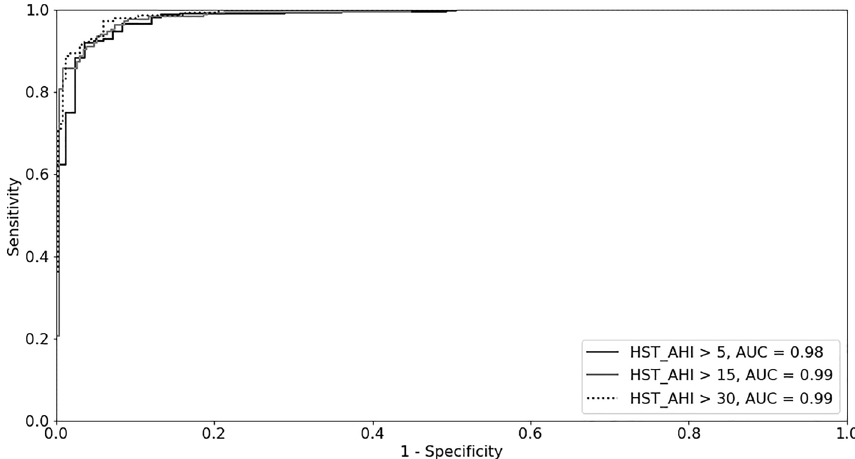
Figure 4. Receiver-operator characteristic curves showing that ODI > 5, > 14, and > 25 events/h were the best cut-offs for detecting at least mild, moderate to severe, and severe OSA, respectively, as evaluated by HST-AHI. The AUC for the ODI cut-offs of > 5, > 14, and > 25 events/h were 0.983, 0.986, and 0.990,